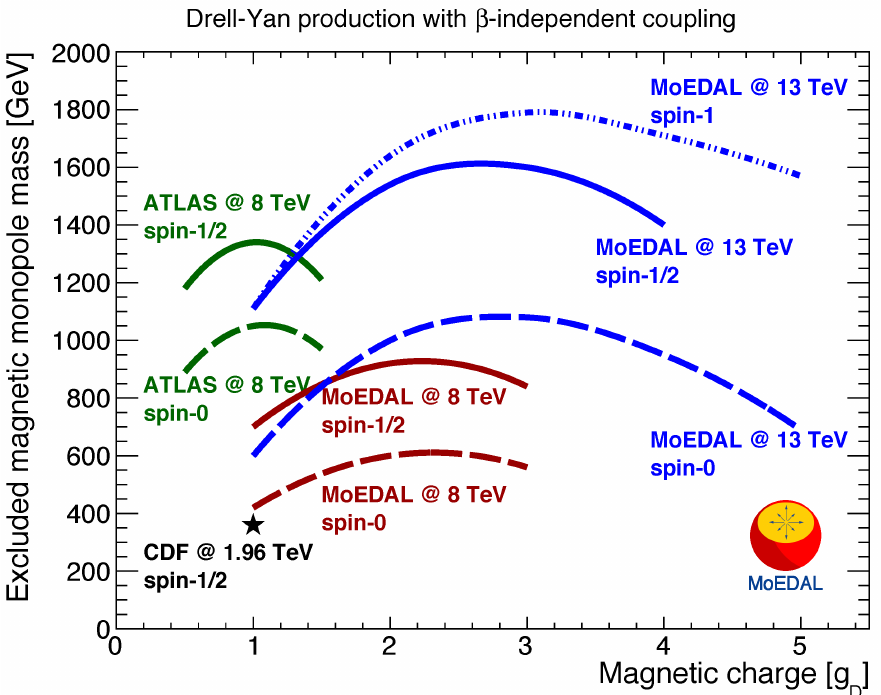
Figure 6. A summary plot of the mass limits placed on Monopole-pair production by MoEDAl, ATLAS and